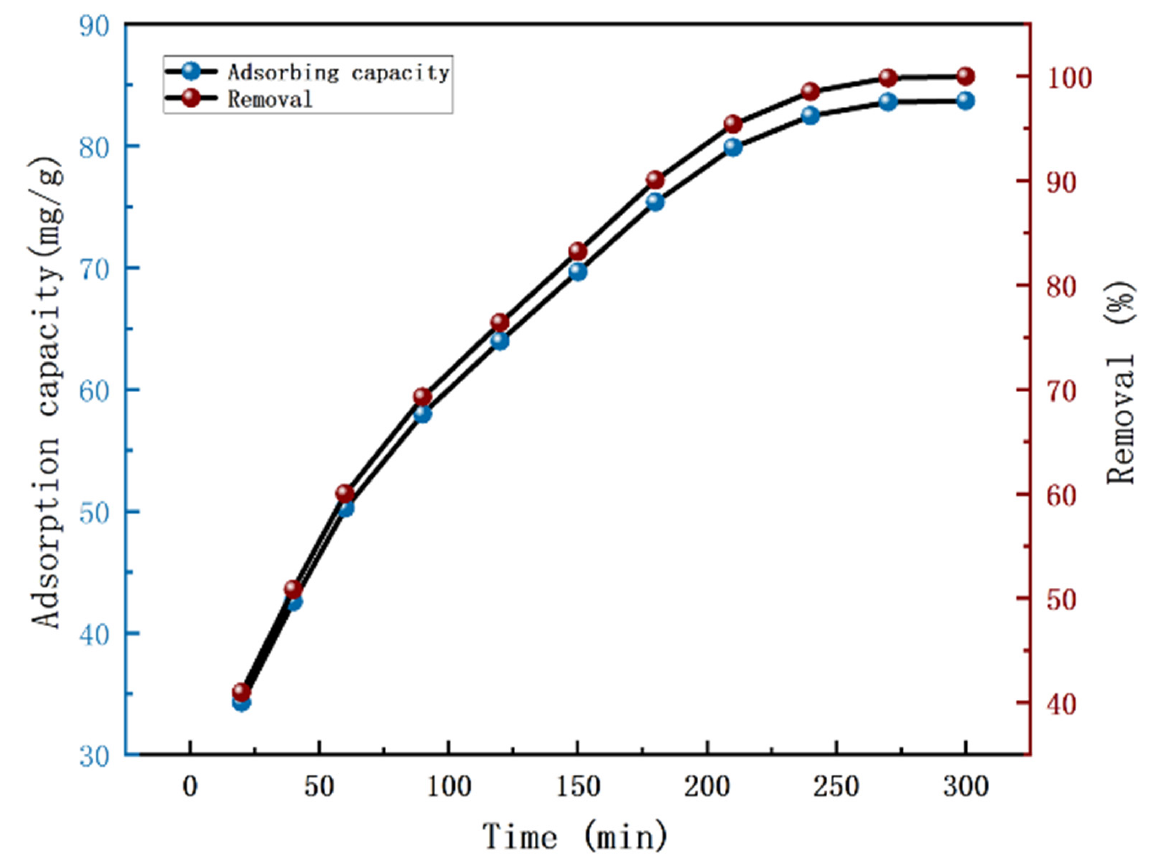
Figure 6. Adsorption capacity of PVDF–2GO@GO ENFM for Cr(VI) under different time.